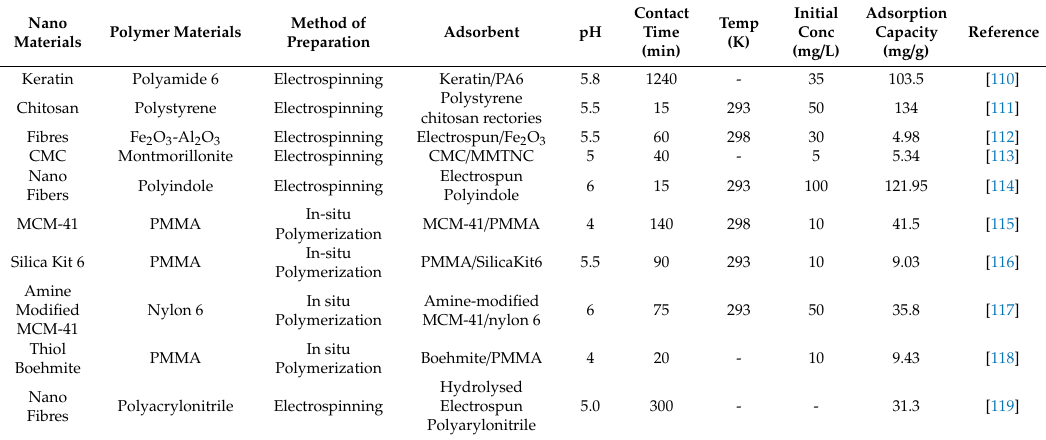
Table 6. Summarised methods of preparation of nanopolymer adsorbent and their maximum adsorption conditions for the removal of copper (II)